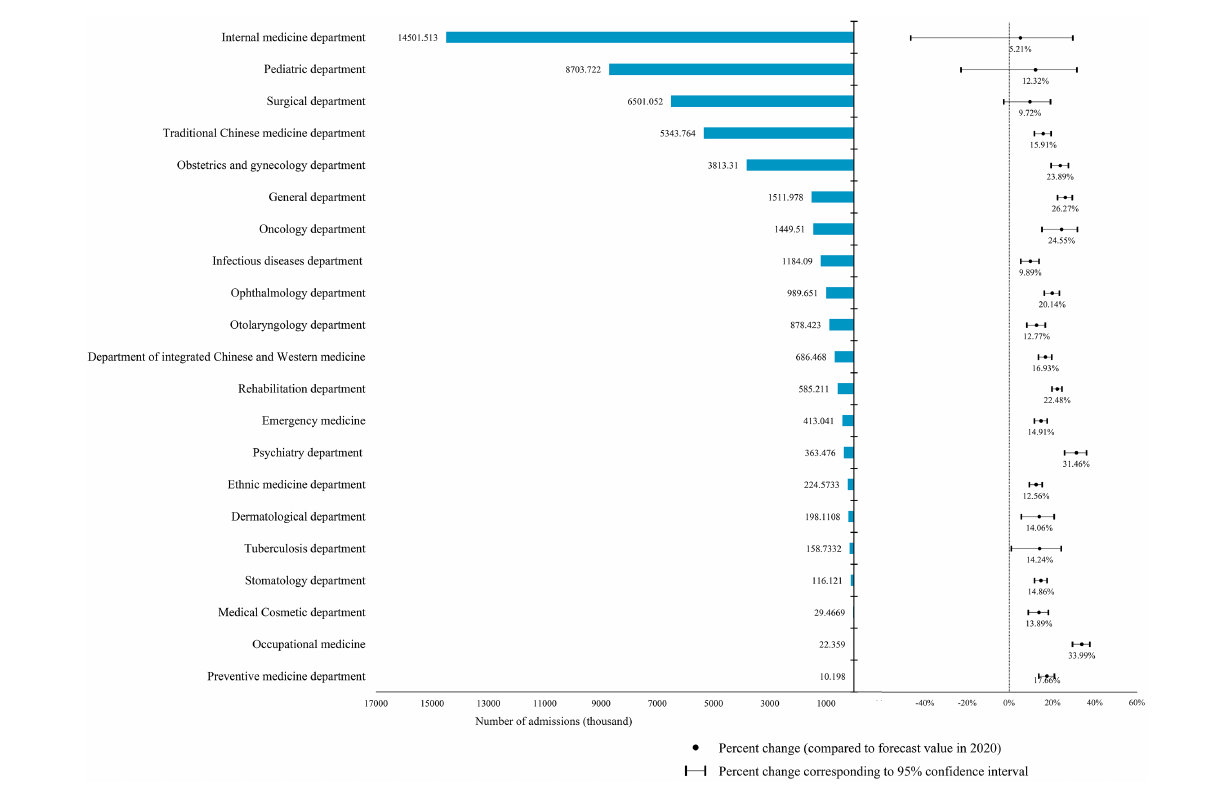
FIGURE 4 The difference between the predicted and actual values of admissions in different hospital departments in 2020 and the percentage change in it.